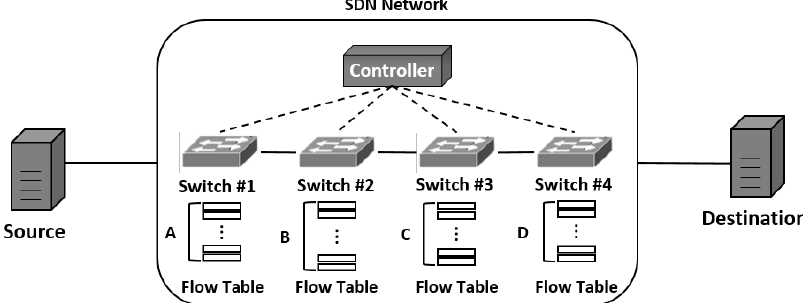
Figure 1. The Software Defined Network (SDN) comprising switches with different sizes of the flow tables.